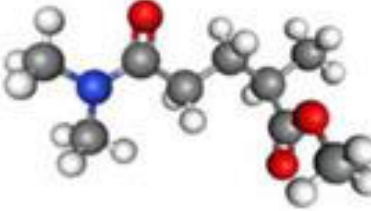
Figure 6. Chemical structure of Rhodiasolv ® PolarClean (Methyl-5-(Dimethylamino)-2-Methyl-5- Oxopentanoate).